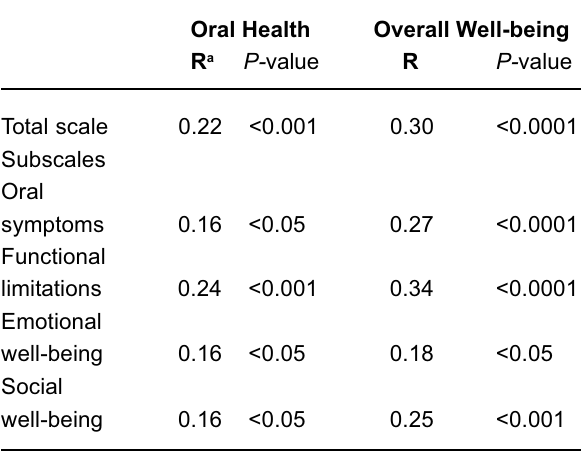
TABLE 3- Construct validity rank correlations between total scale and subscales scores and global rating of oral health and overall well-being